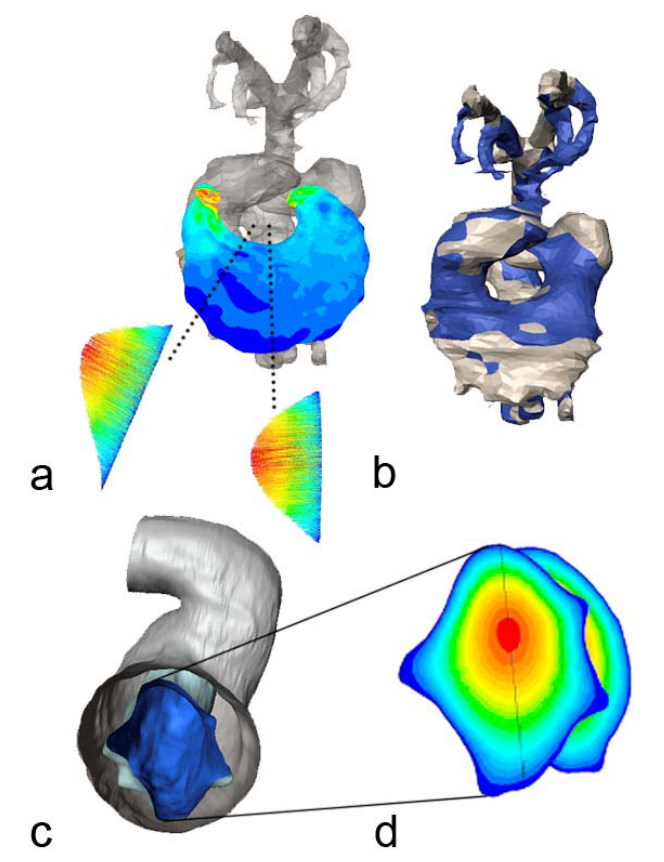
FIGURE 1. Shear stress distribution in the developing heart. Computational fluid dynamics analysis of the predicted shear stress distribution in the HH17 chicken embryonic heart (a) and delineation of the endocardial mRNA expression of the shear response marker KLF2 (b, blue). Both patterns are superimposed on the 3D geometry of the heart and vessels (grey). Note that the predicted shear levels in the inner curvature are higher (light blue in a) compared to the outer curvature (dark blue in a), and that KLF2 mRNA expression is restricted to the high shear areas. The insets in (a) represent the velocity profiles in the dashed areas and show the same inward shift in peak velocity to the inner curvature. A cross- sectional profile of the geometry and the velocity profile is shown in (c) and (d), respectively. Figures a and b are adapted from Hierck et